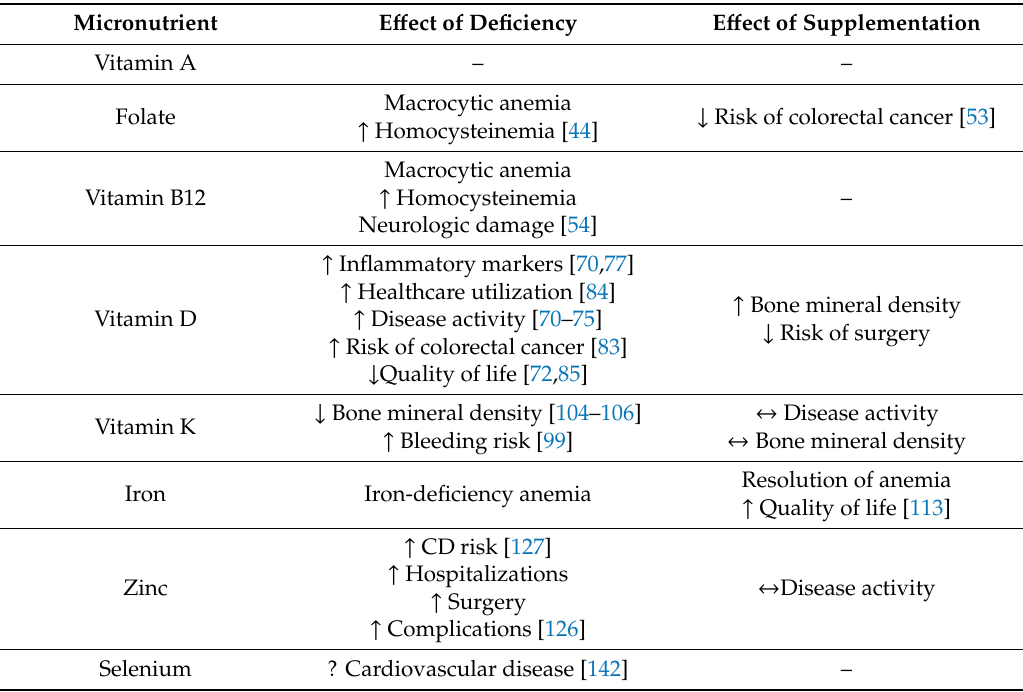
Table 2. Clinical outcomes associated with micronutrient levels in